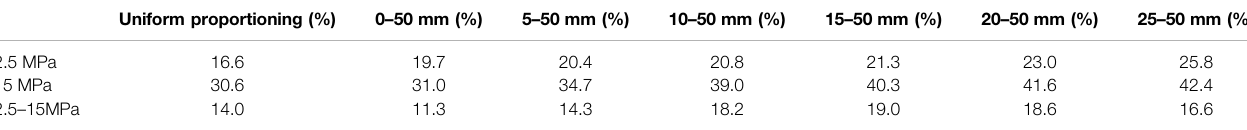
TABLE 1 | Strain variable of gangue samples at different stages. Uniform proportioning (%)